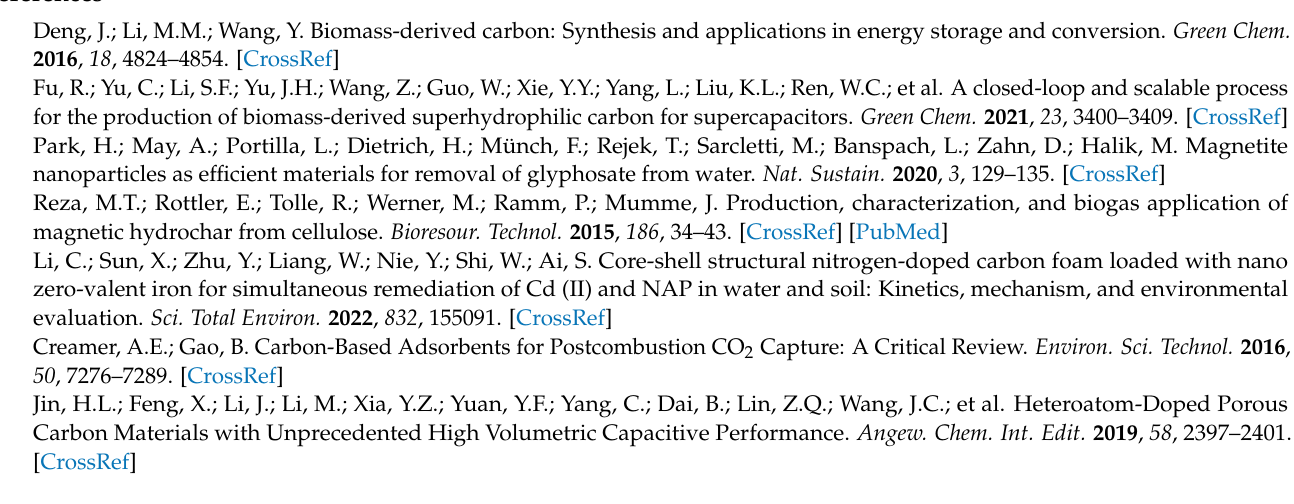
Table S3. Porosity, preparation condition, and elemental compositions of selected NSC materials. The activation conditions were set to be 700 ◦ C. Table S4. The isothermal parameters and kinetic parameters of selected NSC materials for CAP adsorption. Table S5. The isothermal parameters of selected NSC materials for Pb 2+